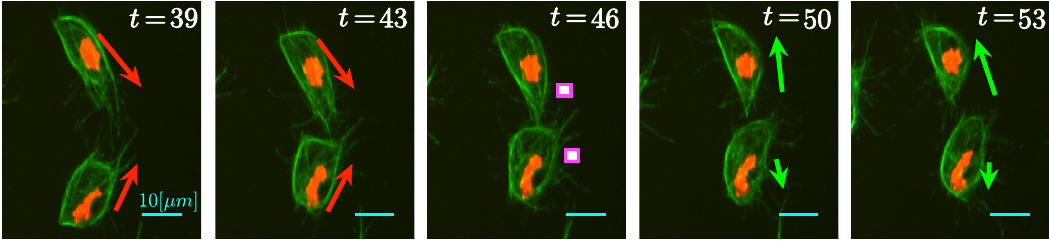
Figure 3. Representation of the movement of two cells before and after the interaction ( clump ). Five frames are shown with arrows which represent the observed direction of movement, before (red) and after (green) the clump . The sizes of the arrows represent the observed speed of movement. Frame 46, in the center, shows an interaction between the two moving cells, forming a clump . Bars 10 µ m.